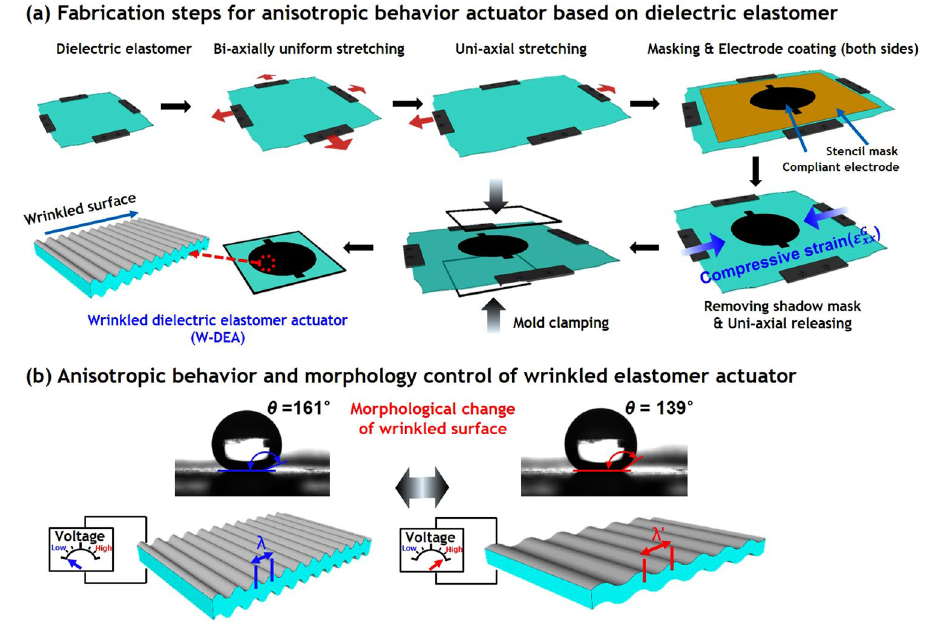
Figure 1. Schematics of the wrinkled dielectric elastomer actuator: the ( a ) fabrication processes, and ( b ) operating principle of the uni-axially wrinkled anisotropic elastomer